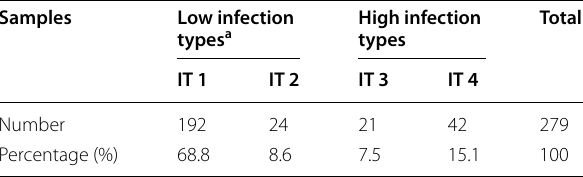
Table 2 Infection types (ITs) of Puccinia striiformis f. sp. tritici isolates (from grass plants with uredia) on highly susceptible wheat cultivar Mingxian